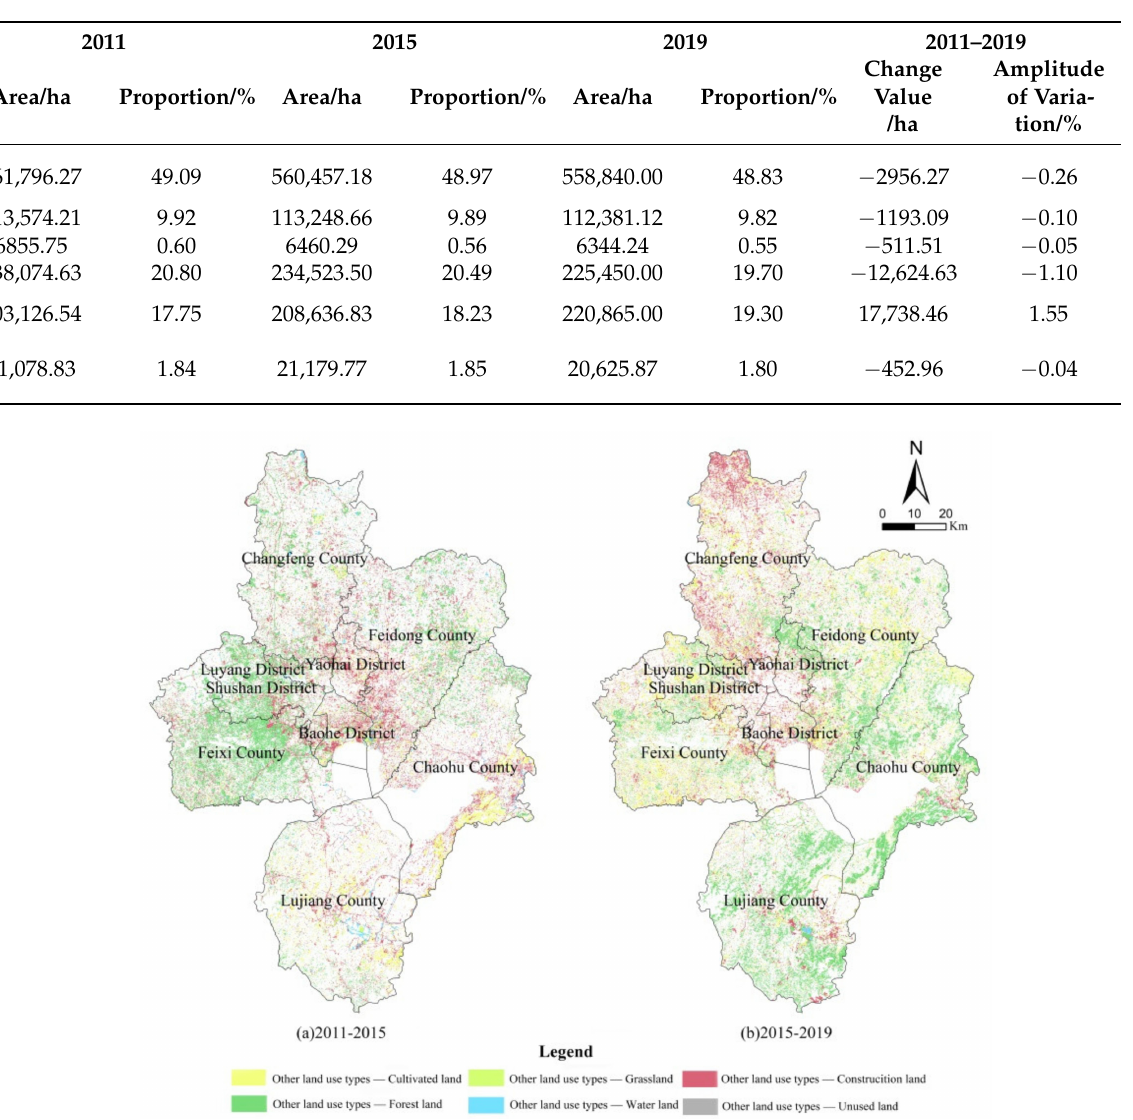
Table 1. Evolution of scale of land use structure.